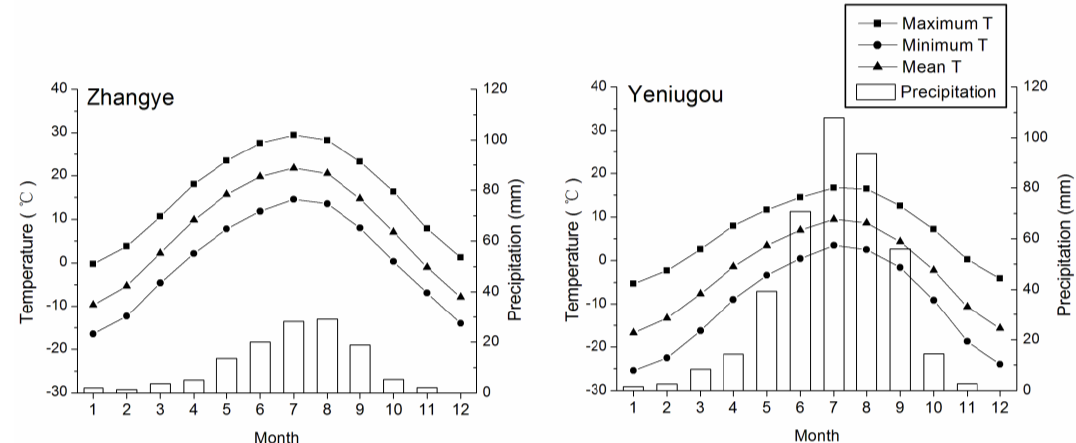
Figure 2. Monthly maximum, minimum, and mean temperatures and precipitation at the Zhangye and Yeniugou stations. Fig. 2 Monthly maximum, minimum, and mean temperatures and precipitation at Zhangye and 2 Yeniugou stations. 3